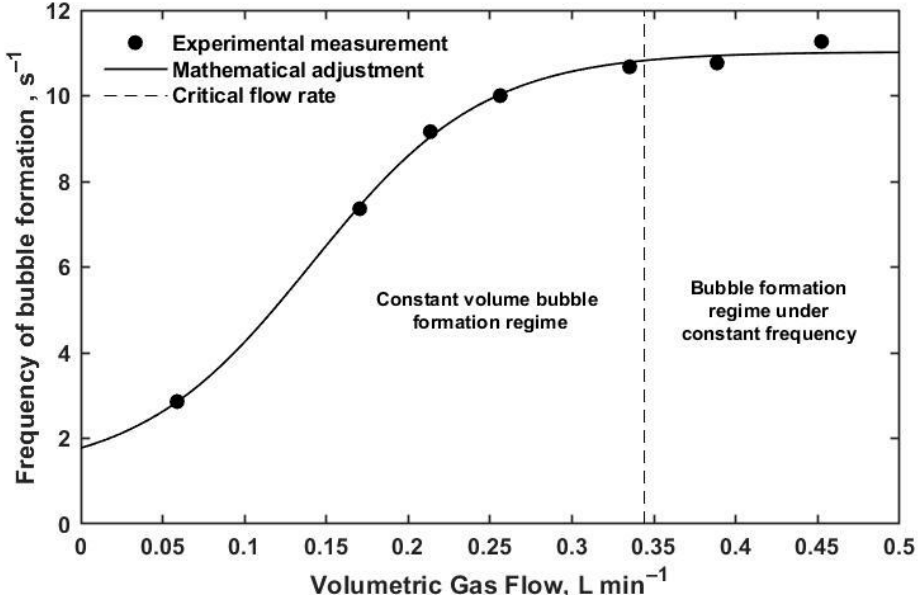
Figure 4. Experimental determination of the bubble formation regimes by the relationship between the frequency and the flow rate of gas supplied through an injector of 0.006 m × 0.004 m located 0.11 m below the surface of the melt.